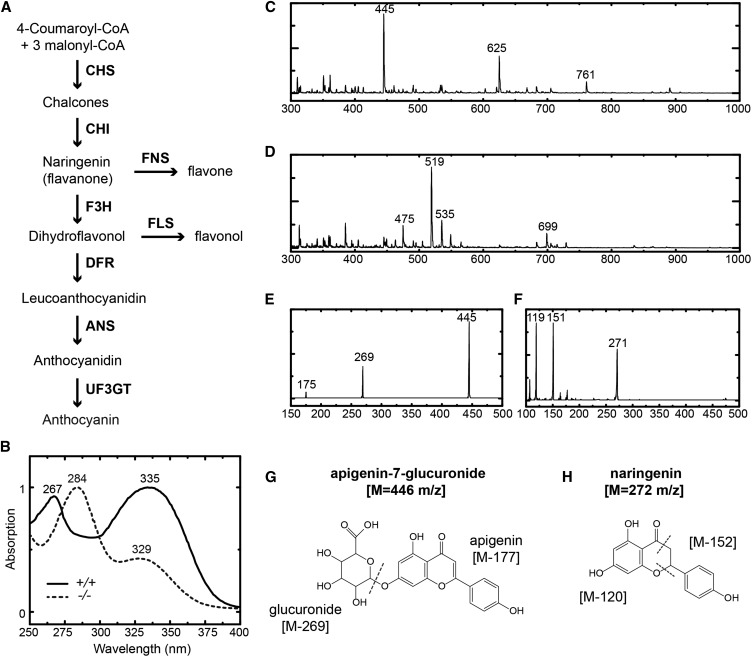
Flavonoid analyses of petal extracts. (A) A schematic of the anthocyanin biosynthetic pathway, with branches leading to flavone and flavonol biosyntheses. (B) Absorption spectra of the wild-type LF10 (solid line) and homozygous mutant (dotted line) petal extracts in 60% methanol solution. Spectra were normalized to one at the absorption maxima. The heterozygous mutant showed the same spectrum as the wild-type. (C and D) MS-ESI (negative mode) of flavonoid extract from wild-type petals (C) and homozygous mutant petals (D). (E) MSMS-ESI of the 625 m/z molecular ion in (C) (the 761 m/z molecular ion showed a very similar fragmentation pattern). (F) MSMS-ESI of the 519 m/z molecular ion in (D). (G and H) Chemical structures of apigenin-7-glucuronide (G), naringenin (H) and the respective cleavage patterns identified in (E) and (F) indicated by dotted lines. Chemical structures (G and H) were generated using ChemDrawPrime software (v16.0). ANS, anthocyanidin synthase; CHI, chalcone isomerase; CHS, chalcone synthase; DFR, dihydroflavonol 4-reductase; ESI, electrospray ionization; F3H, flavonoid 3-hydroxylase; FLS, flavonol synthase; FNS, flavone synthase; MS, mass spectrometry; UF3GT, UDP-3-O-glucosyltransferases.